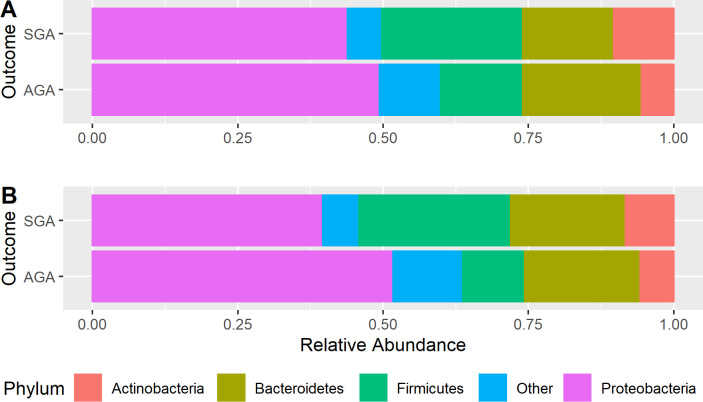
Relative phyla abundance of the gut microbiota according with weigh adequacy.Each stacked bar represents the mean relative abundance of weight adequacy group at birth (A) and at moment of discharge (B).